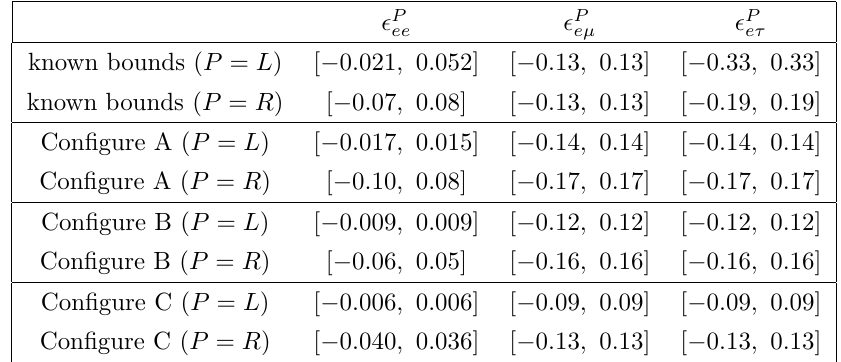
Table 3 . Current NSI bounds from ref. [3] compared with future 51 Cr-LXe bounds (Con(cid:12)gures A, B, and